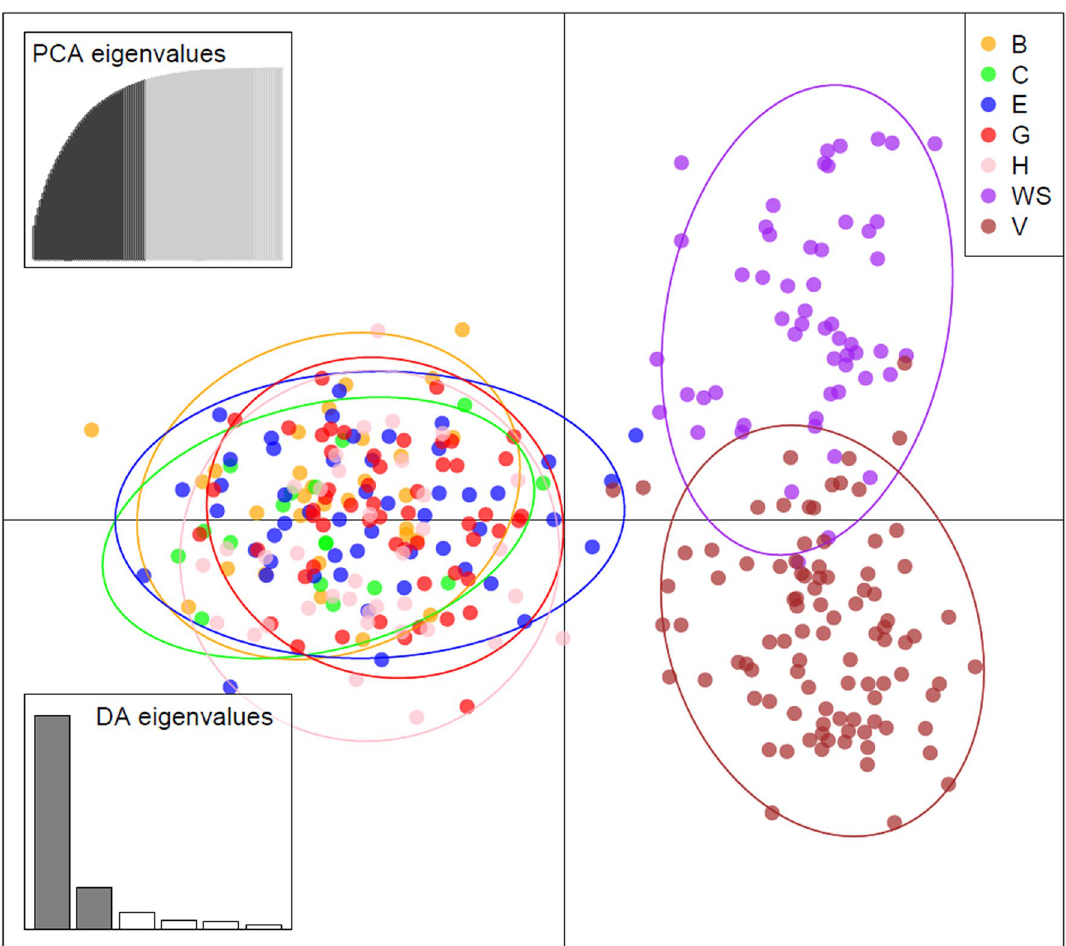
Figure 2. Discriminant analysis of principal components (DAPC) showing the principal components and 95% confidence ellipses of all Seriola lalandi samples: B—North Blinder, C—Yzerfontein, E—Cape Point, G—Struis Bay, H—Port Elizabeth. V—Vema, WS—Walters Shoal. PCA, principal component analysis; DA, discriminant